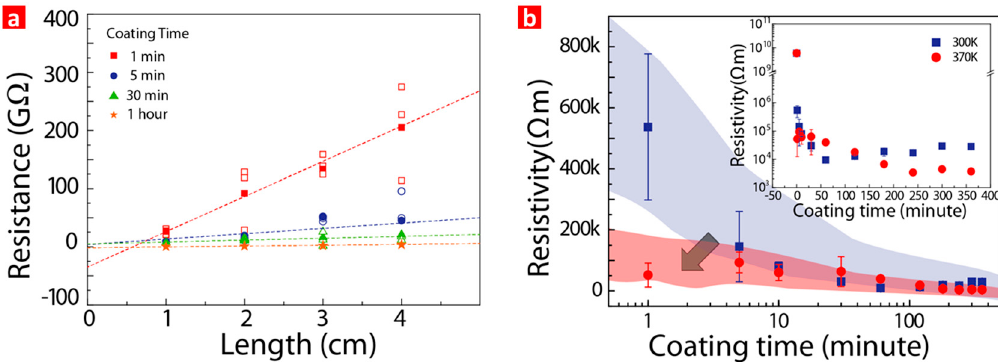
Figure 3. ( a ) SF resistance depending on distance at different coating times (Open symbols are experimental values whose average value is marked as solid symbol); ( b ) SF resistivity as a function of coating time at different coating temperatures.